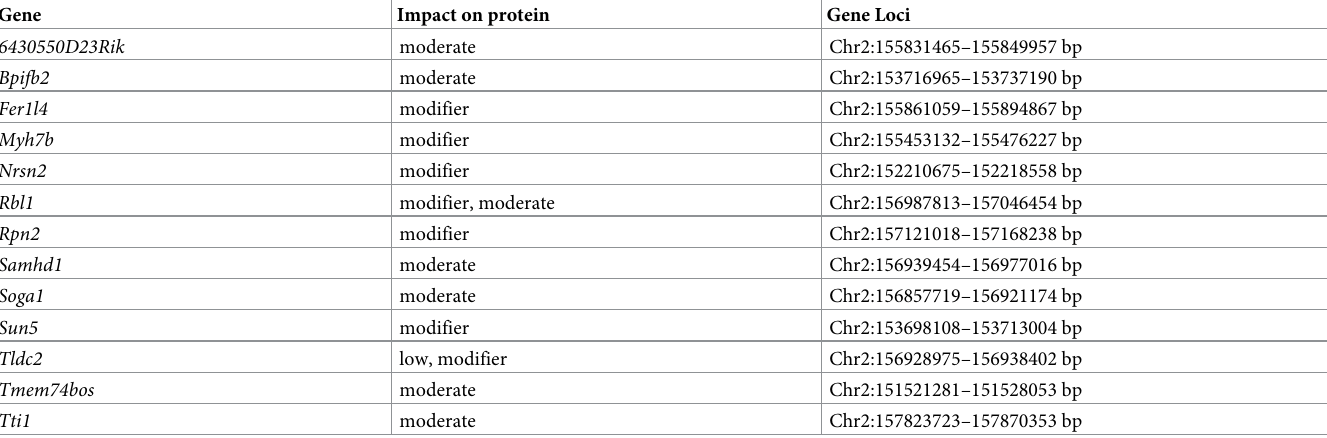
Table 2. Candidate genes from median survival QTL associations that had SNP differences corresponding to haplotype differences. The impact the SNP difference is predicted to have on the resulting protein is shown. “Moderate” are nondisruptive variants that might change protein effectiveness, “Modifier” are noncoding variant or a variant affecting a noncoding part of a gene., and “Low” are variants assumed to be unlikely to change protein